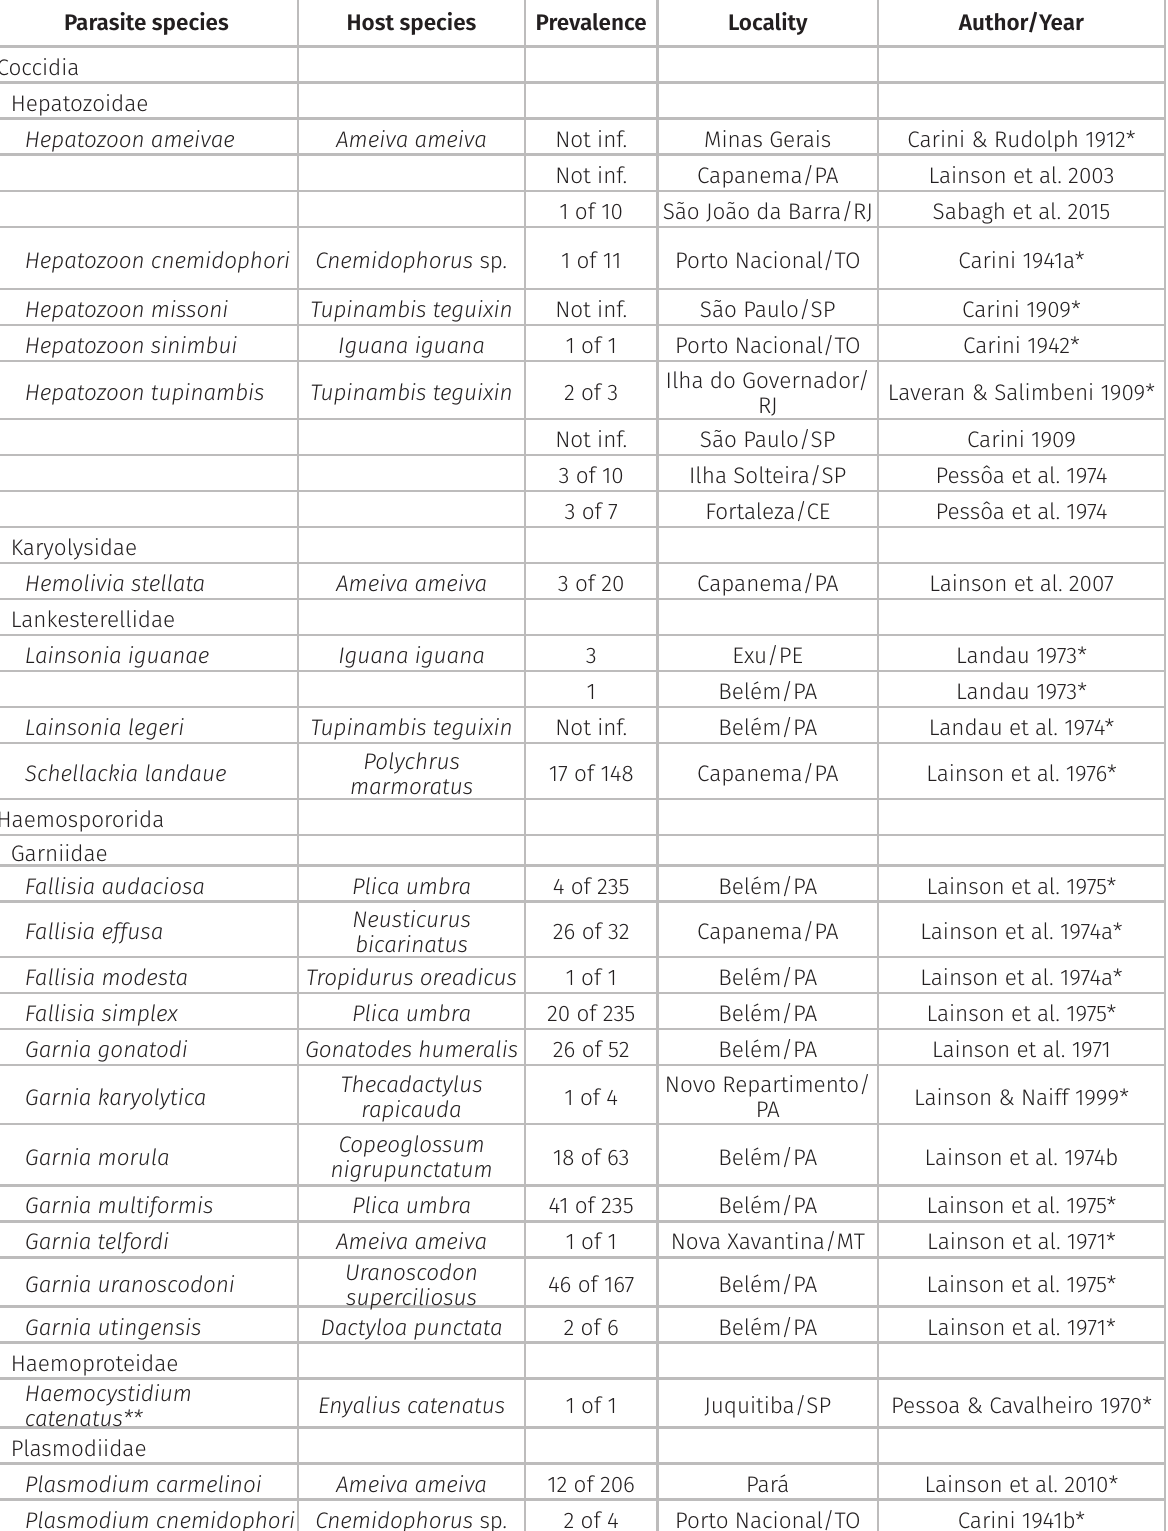
Table I. Checklist of haematozoan parasite species occurring in Brazilian lizards. Parasite